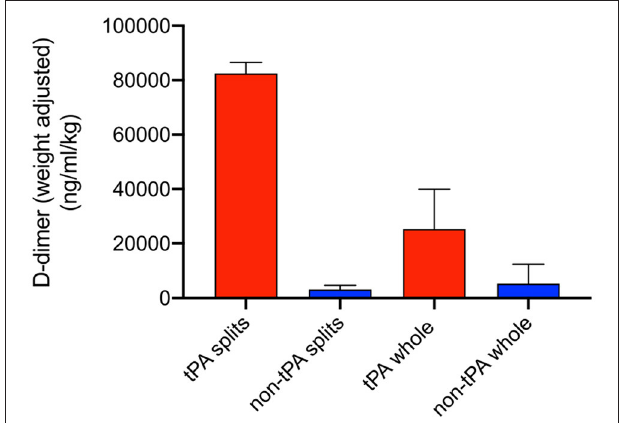
FIGURE 3 | Weight-adjusted perfusate D-dimer levels at T = 1h of normothermic machine perfusion (NMP). Higher D-dimer levels were seen in tPA splits and tPA whole livers compared to non-tPA controls. Error bars represent standard